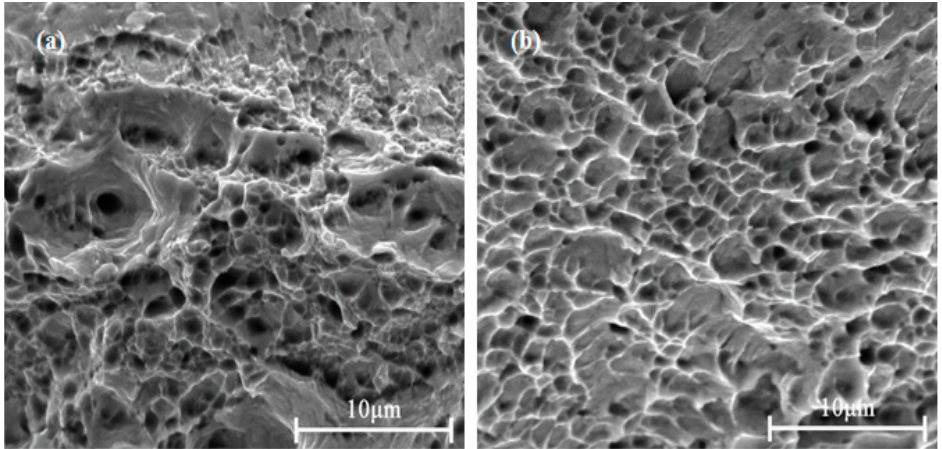
Figure 6. Fracture surface SEM images of the Cu-1.34Ni-1.02Co-0.61Si alloy after cold rolling at 47% reduction: ( a ) without DCT; ( b ) with the DCT in liquid nitrogen for 48 h.